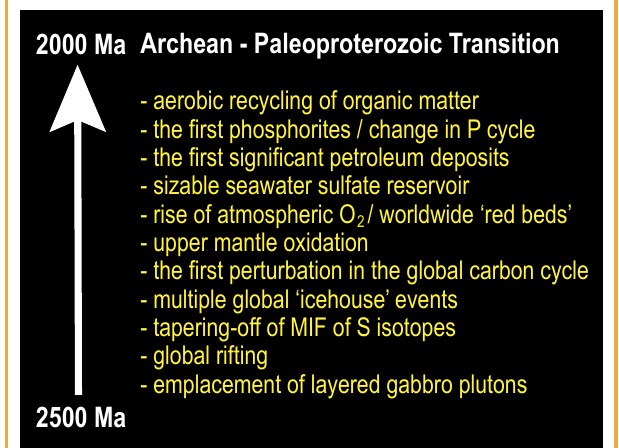
Archean - Paleoproterozoic